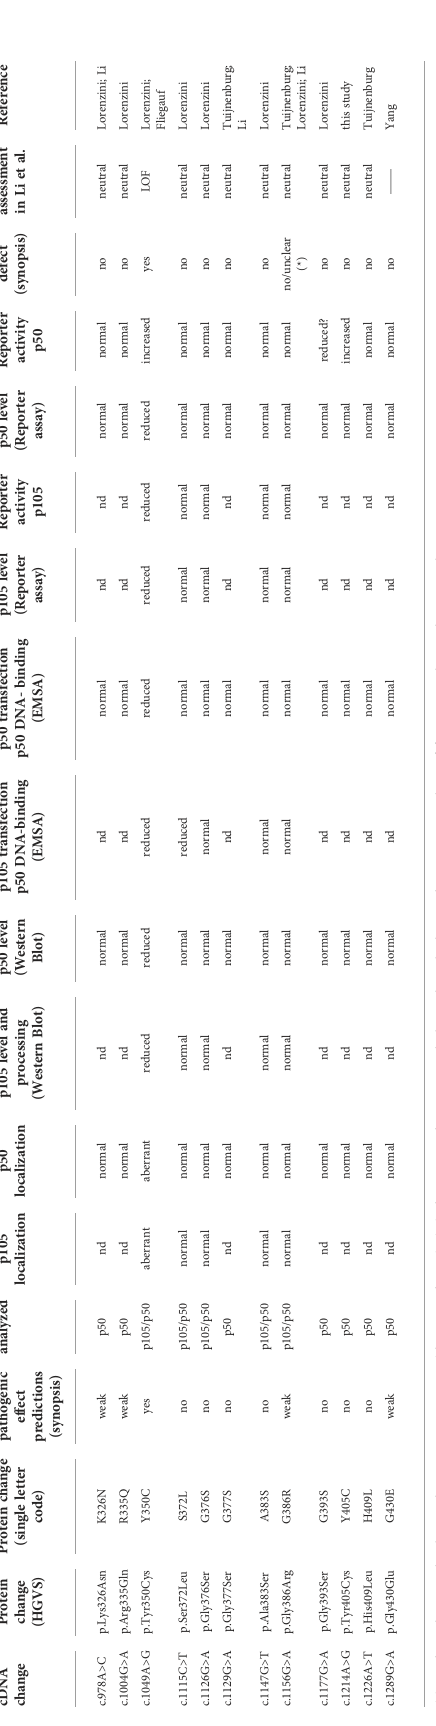
Cells were seeded onto collagenized glass coverslips in 24- well plates and transfected with the indicated constructs. Cells were fi xed with 4% paraformaldehyde (PFA), nuclei were stained with Hoechst 33342 (Sigma/Merck, Darmstadt Germany) and coverslips were mounted onto glass slides. Microscopic photographs were taken using a Zeiss Axio Observer (Carl Zeiss, Jena, Germany) equipped with a 40x/ 0.75 objective and processed with ZEN-blue software.